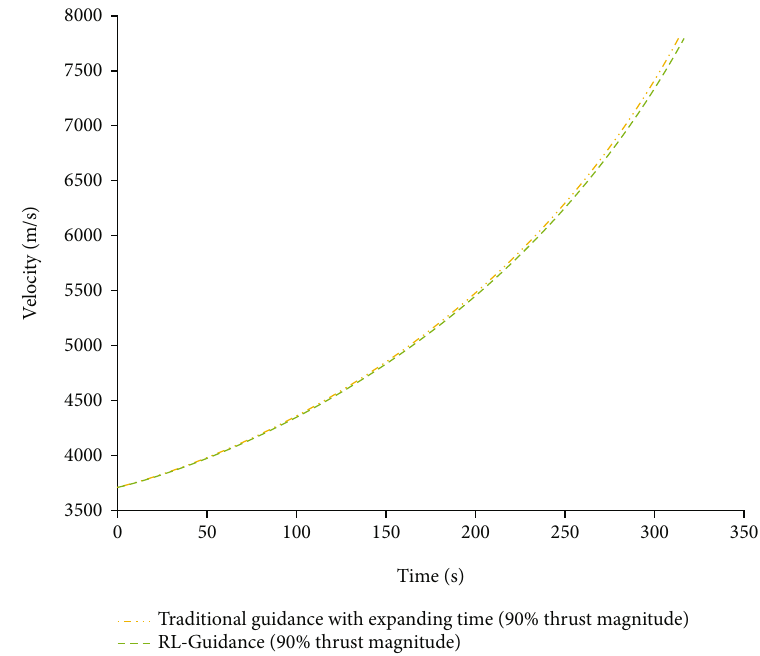
Figure 12: Velocity comparison of RL-guidance and traditional guidance with expanding fl ight time in experiment